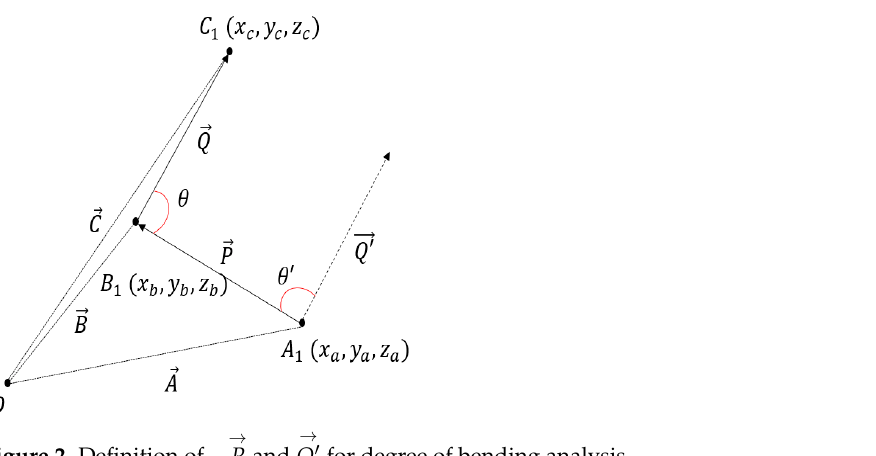
Figure 2. Definition of −𝑃(cid:4652)⃗ and 𝑄 (cid:4593) (cid:4652)(cid:4652)(cid:4652)(cid:4652)⃗ for degree of bending analysis.